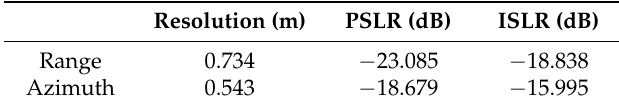
Table 7. The performance of compression after stop-and-go correction.